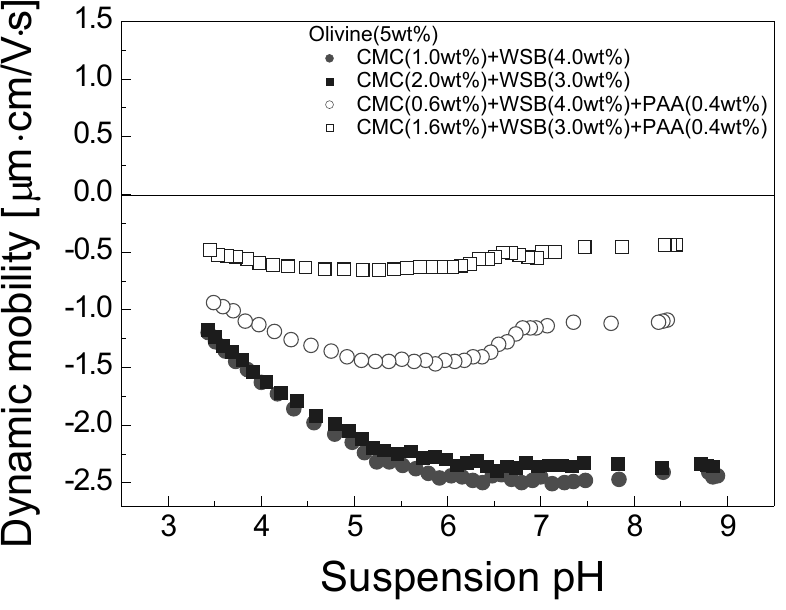
Fig. 1 Electrokinetic behavior of C/LiFePO 4 suspensions prepared at a solid mass fraction of 5% and containing CMC and WSB, with and without